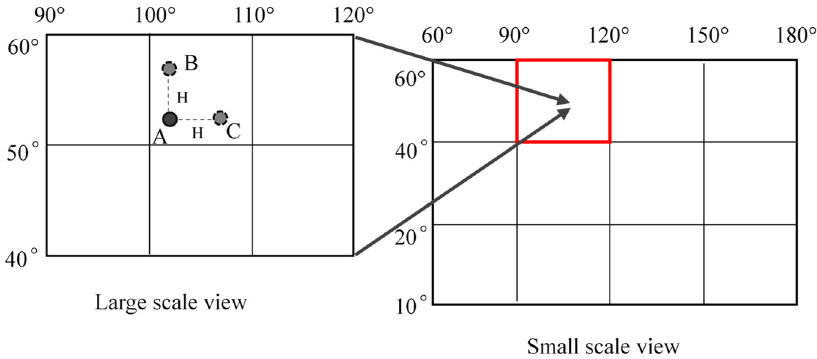
Figure 2. Schematic diagram of multi-scale streamline step length intervention. Point A is a streamline tracking point, point B is generated by point A after latitude increment, and point C is generated by point A after longitude increment, besides, the increment values are both equal step length intervention intensity coefficient 𝐻 .